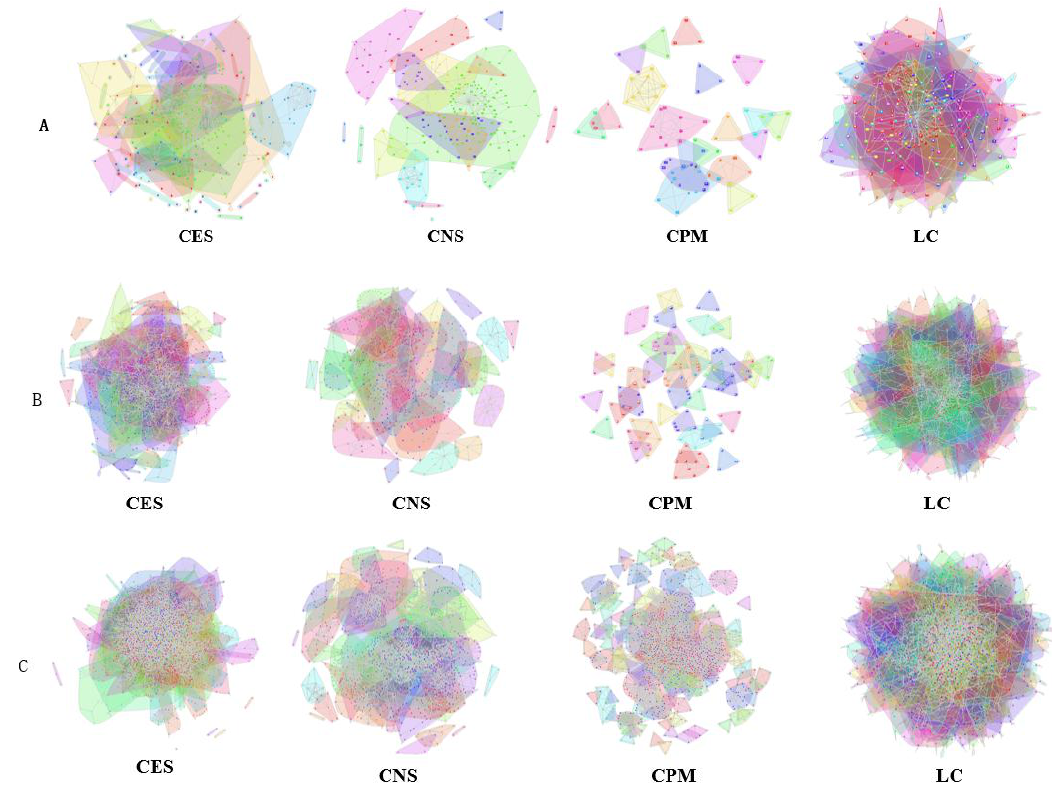
Figure 7. Visualization of the predicted PPI network using four algorithms. ( A ) M. musculus dataset. ( B ) E. coli dataset. ( C ) Cerevisiae dataset.